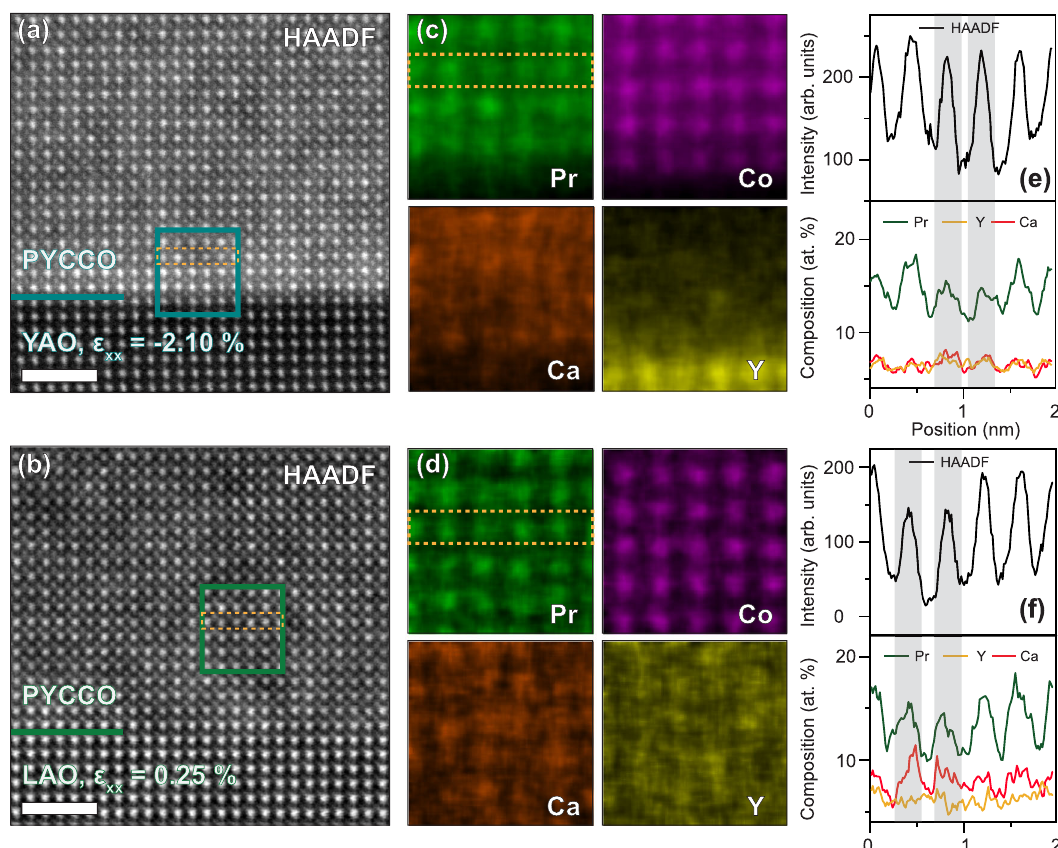
L α (yellow)intensitiesintheboxedregionsin( a,b )(onYAOandLAO,respectively). (Note that due to the low Y content of these fi lms, the Y values are subject to signi fi cant uncertainty). ( e,f ) Line scans of the HAADF intensity (top) and normal- izedelementalatomicpercentages(bottom)alongtheatomiccolumnshighlighted in ( a-d ) (on YAO and LAO, respectively).The grey vertical bands highlight columns with larger HAADF intensity and compositional fl uctuations, as discussed in the